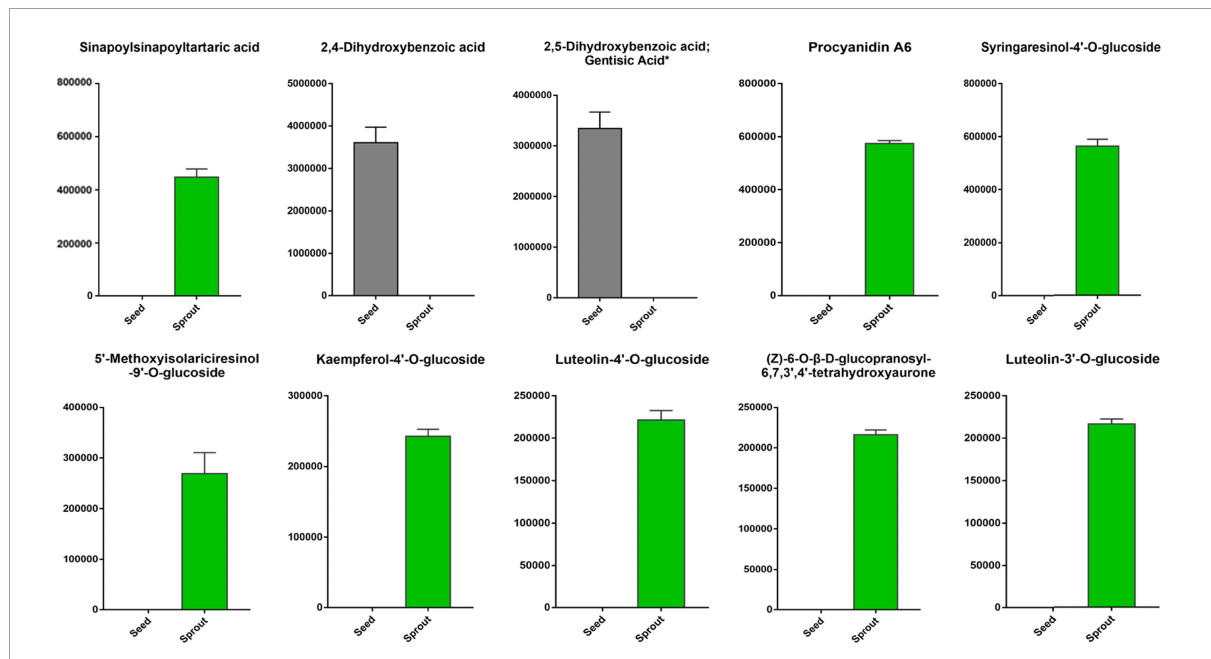
FIGURE5 The top 10 differentially abundant phenolic compounds with the largest fold change (FC) value in the pairwise comparison of white radish seed and sprout.